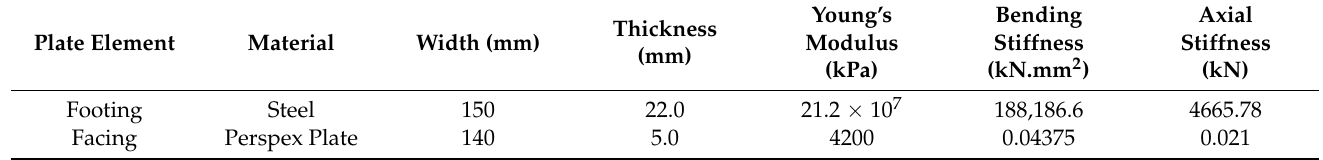
Table 3. Slope facing and foundation plate properties.